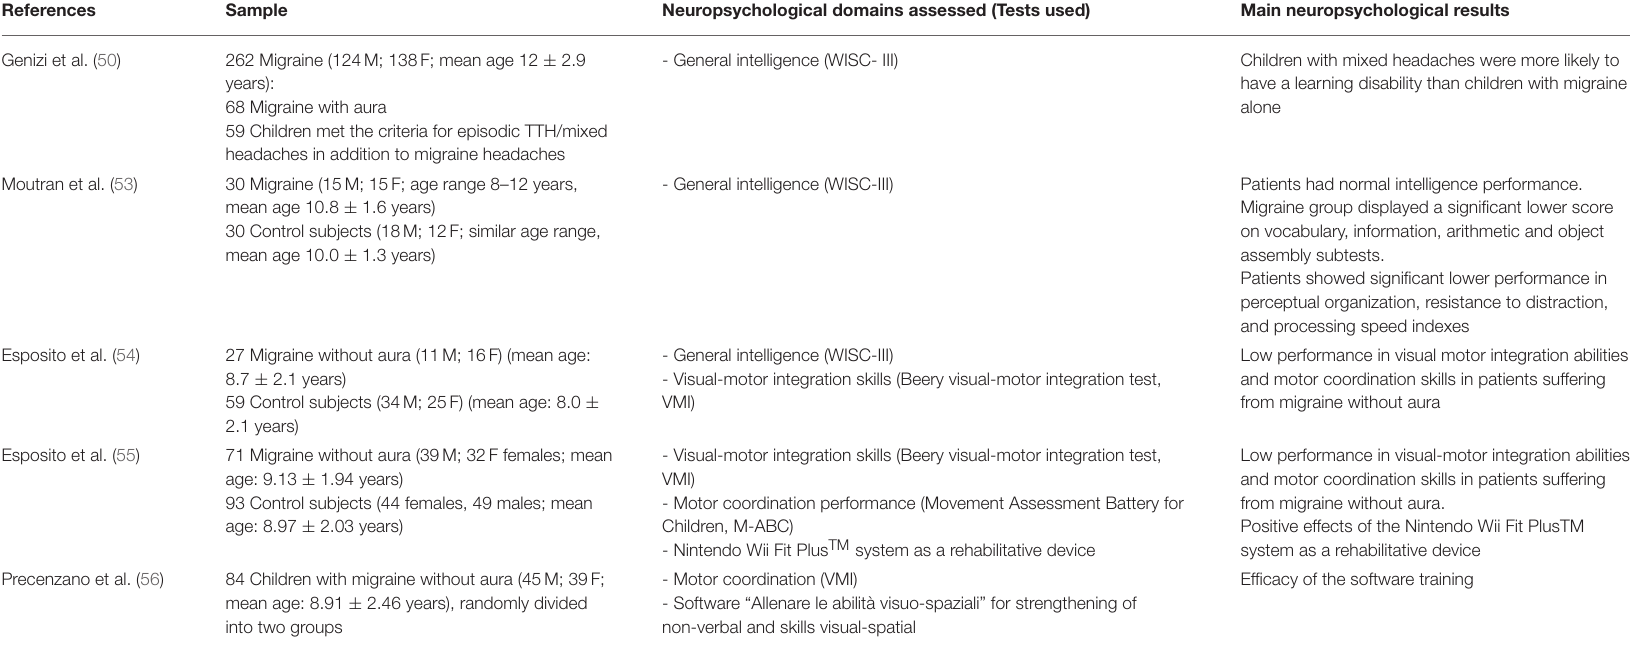
- Visual-motor integration skills (Beery visual-motor integration test, VMI) - Motor coordination performance (Movement Assessment Battery for Children, M-ABC) - Nintendo Wii Fit Plus TM system as a rehabilitative device - Motor coordination (VMI) - Software “Allenare le abilità visuo-spaziali” for strengthening